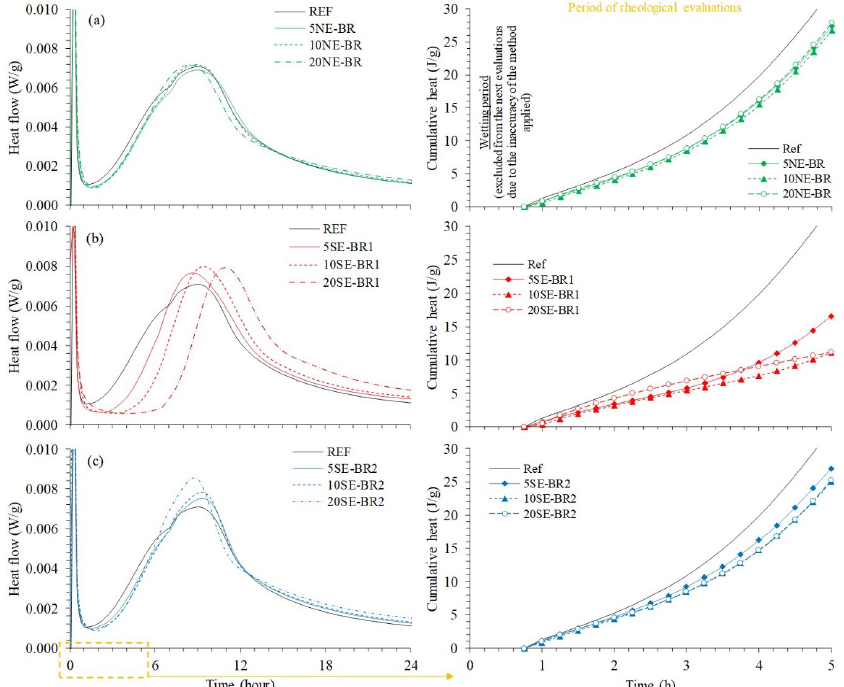
Figure 7 H eat flow released during the hydration reaction of Portland cement blended with different BR types and content. In (a) is presented the results for NE-BR, in (b) for SE-BR1, and (c) SE-BR2. On the right are presented the cumulative heat up to 5 hours of evaluation, the period of rheological evaluations. It was excluded the heat released during the wetting period due to the inaccuracy of the method applied in this work for this